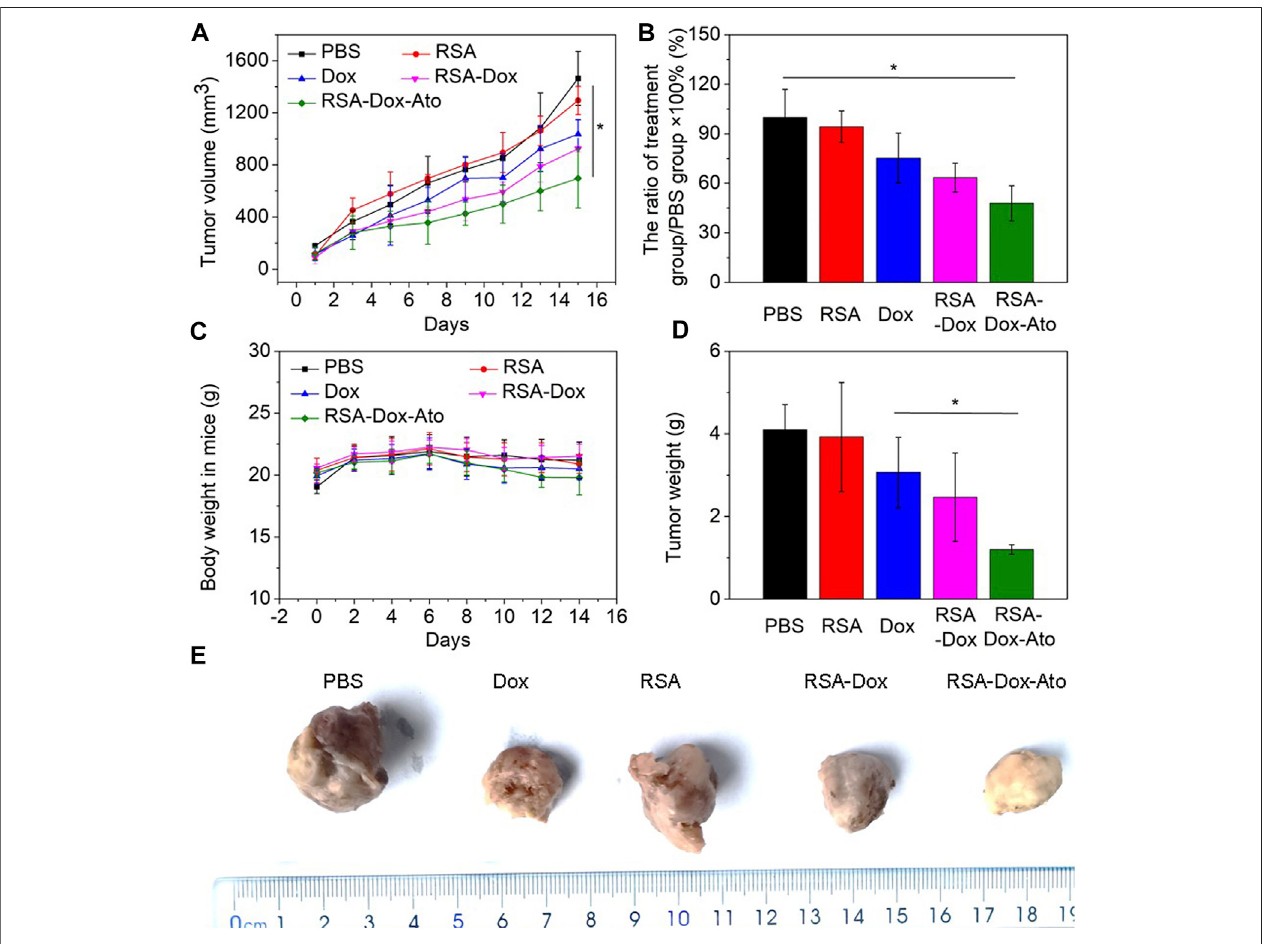
FIGURE 4 | The behavior of RSA-Dox-Ato NPs post-i.v. injection in vivo . (A) The tumor volume growth curves of 4T1 tumor-bearing mice injected with nanodrugs for14 days.Thedatawererepresentedasthemean±SD( n =5, p p < 0.05, pp p < 0.01); (B) Thetumorgrowthinhibitionratioofeachgroup; (C) Thebodyweightcurveof 4T1tumor-bearingmiceupontheperiodoftreatment; (D) Thetumorweightcurveof4T1tumor-bearingmiceupontheperiodoftreatment; (E) Representativephotosof tumor-bearing mice from different treatment groups at the end of the